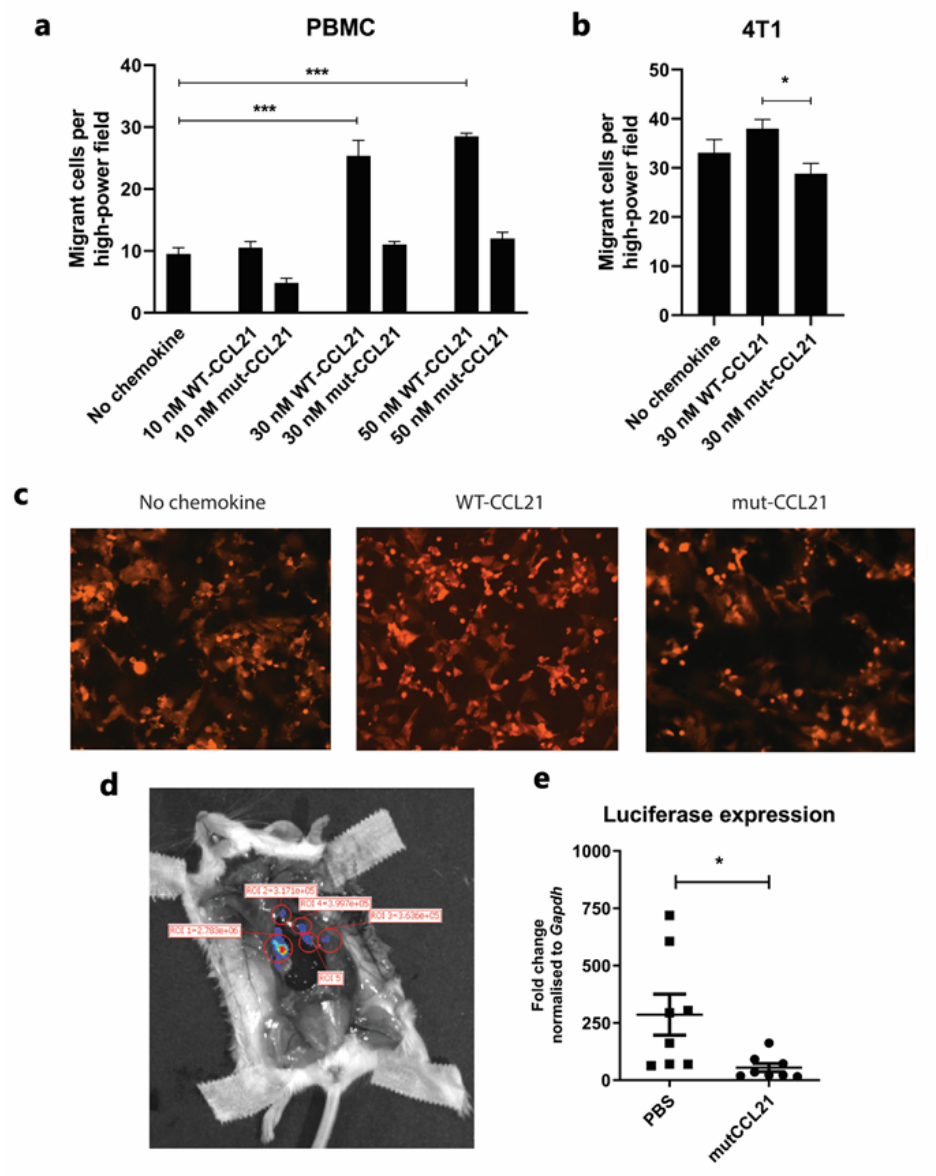
Figure 6. Trans-endothelial chemotaxis and in vivo migration. Trans-endothelial chemotactic migration of PBMCs ( a ) and 4T1 cells ( b ) though a HMEC-1 monolayer towards several concentrations of WT and mutated CCL21 after optimised incubation time. Graphs show the number of migrated cells adhered to the filter per power field. Data represent the mean ± SEM of three inde- pendent experiments and statistical significance was calculated using one-way ANOVA with